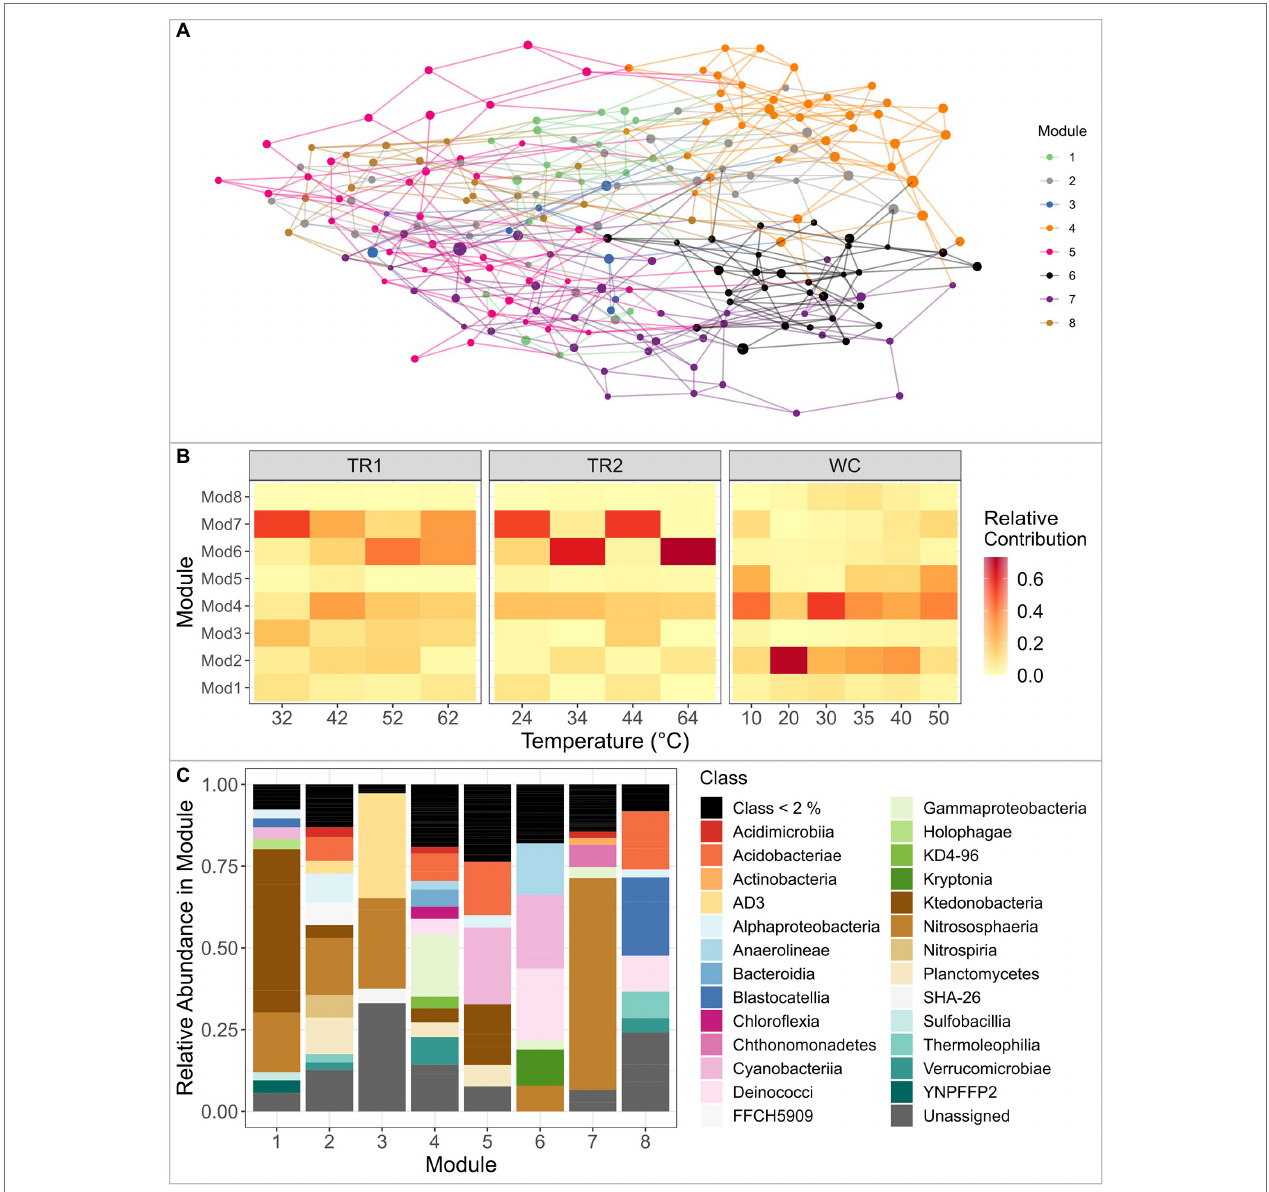
FIGURE 6 | (A) Visual representation of the undirected co-variation network of the trimmed ASV data set from all samples. Nodes and lines are color-coded by module, as defined by the igraph fast greedy modularity optimization algorithm. Node size reflects the mean center log-ratio abundance of the ASV across all samples. (B) Heat map of the relative contribution of ASVs from each of the modules to the total microbial community in each sample, clustered by transect. The x-axis is ordered by increasing sample temperature within transect. TR1: Tramway Ridge 1 transect; TR2: Tramway Ridge 2 transect; WC: Western Crater transect. (C) Microbial composition of each module from the network analysis ordered alphabetically. Size of the bars reflects the relative abundance of that class within the module. Only classes with a relative abundance above 2% are plotted for ease of